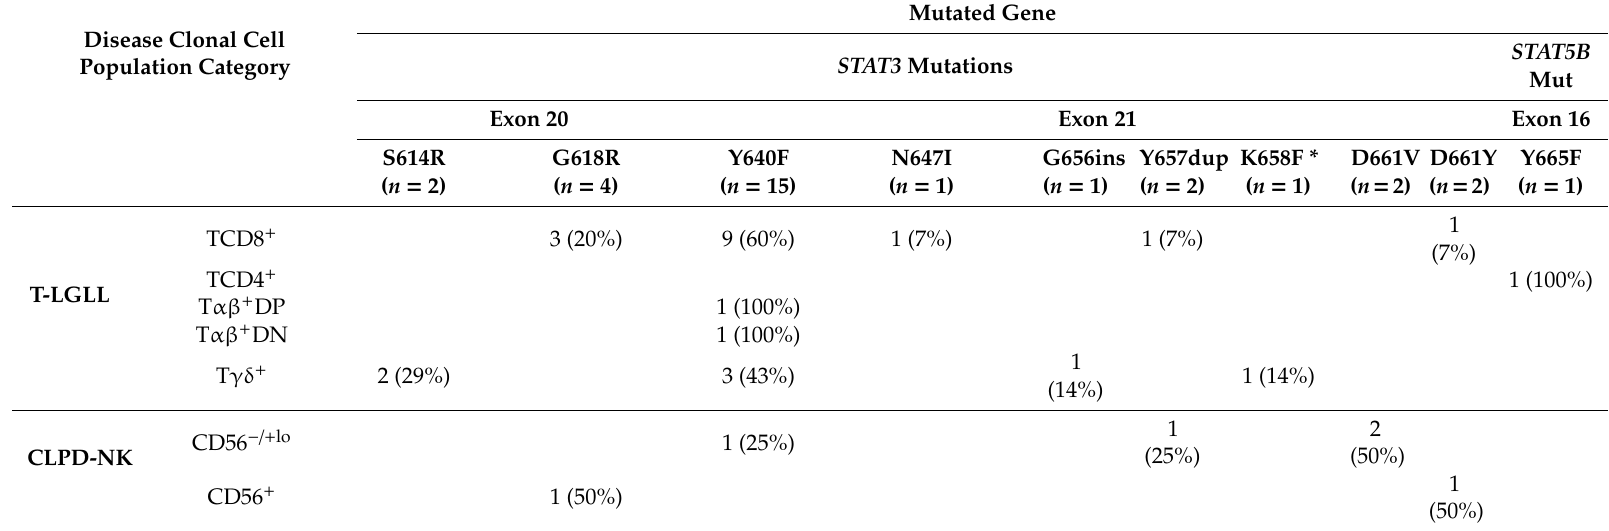
Panel B: Specific STAT3 / 5B Gene Mutations Identified in Purified Clonal T / NK-cell LGL Populations ( n = 31) from 28 T / NK-LGLL Patients Disease Clonal Cell Population